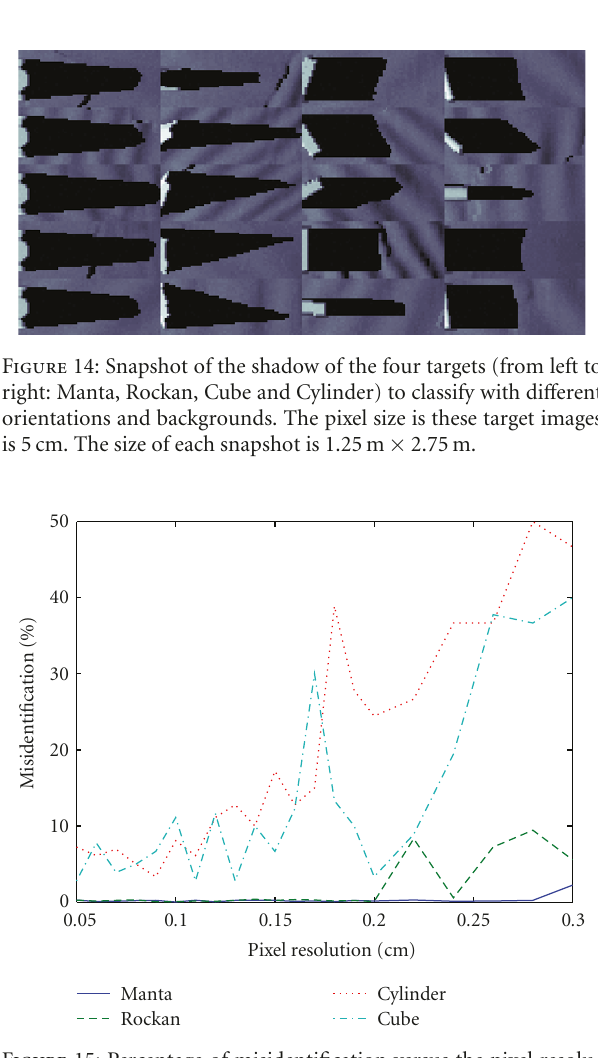
Figure 15: Percentage of misidentification versus the pixel resolu- tion for various target types. This considers the shadow of the target and not its